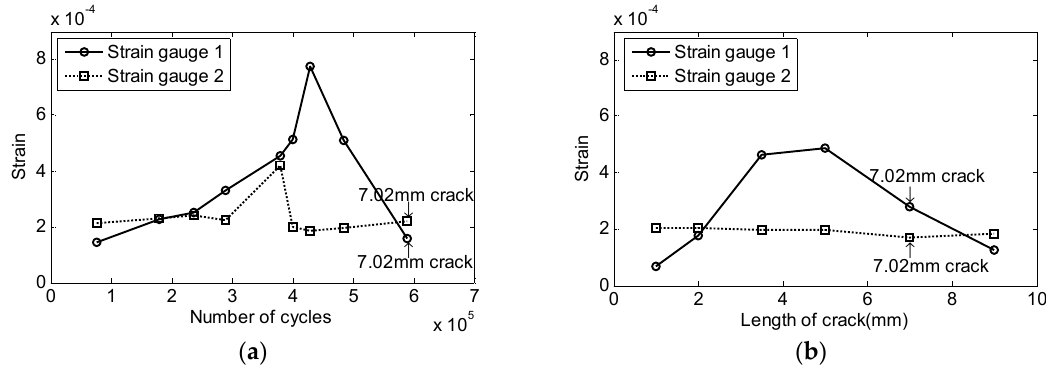
Figure 11. The comparison of experimental and numerical strain history; ( a ) experimental measurement; and ( b ) numerical measurement.